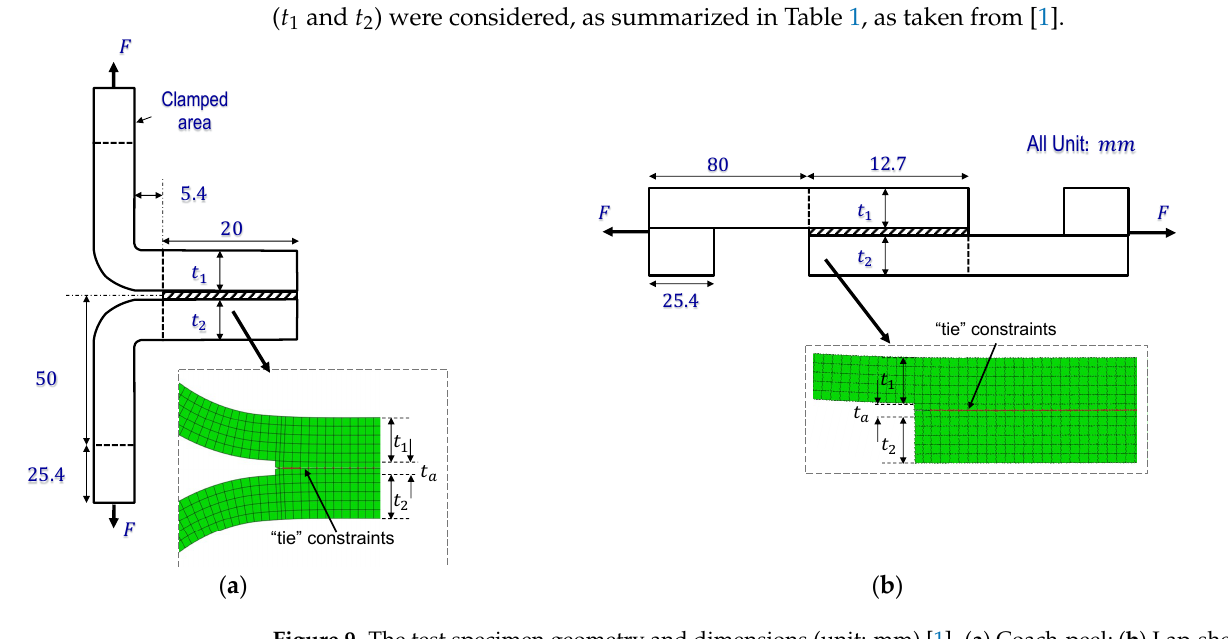
Figure 9. The test specimen geometry and dimensions (unit: mm) [1]. ( a ) Coach-peel; ( b ) Lap-shear. Table 1. The adherend thickness combinations of the specimens [1].